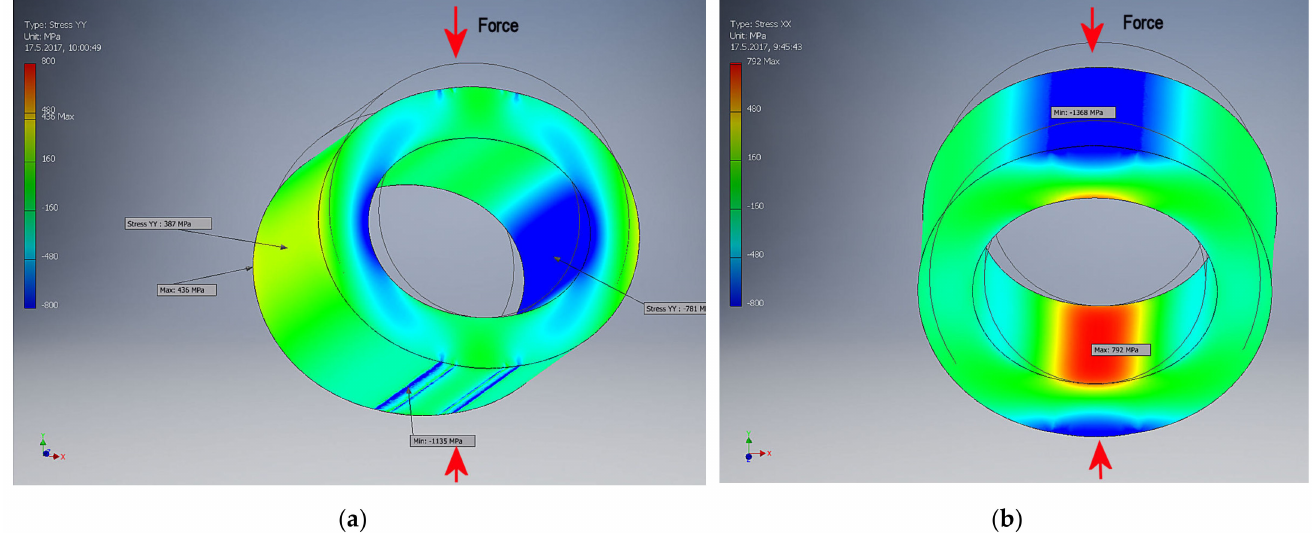
Figure 2. Schematically shown stress maximums in O-rings, where blue is compressive and red is tensile stress; ( a ) yy stresses and ( b ) xx stresses (FEM analysis done by Autodesk Inventor Version